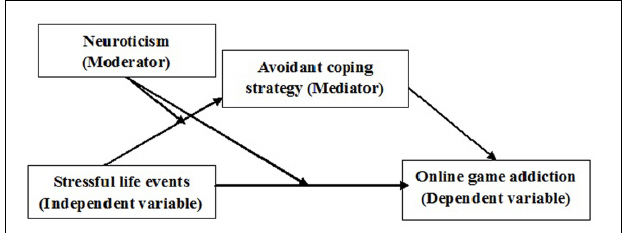
FIGURE 1 | Hypothesized mixed